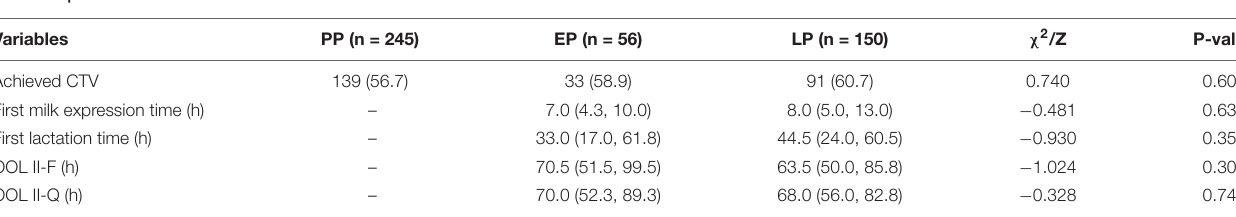
TABLE 2 | Maternal lactation